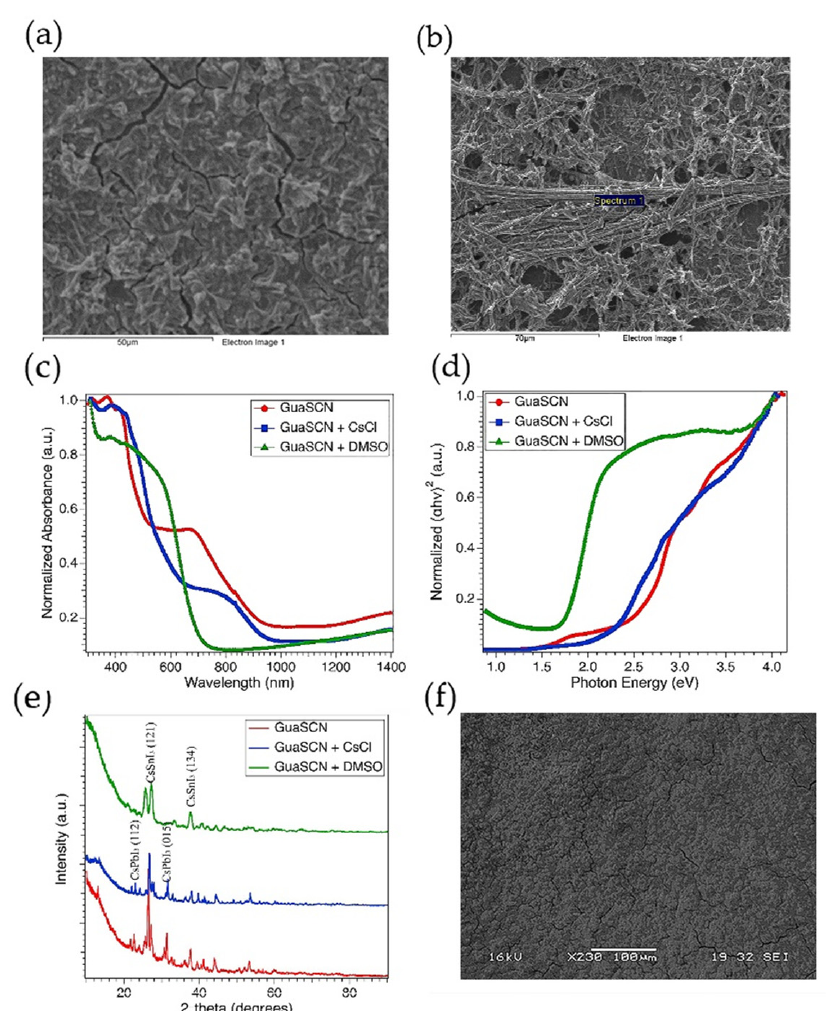
Figure 5. ( a ) Direct bandgap spectra shown in Tauc plot for GuaSCN film (red), when CsCl was added (blue), and when DMSO was used with other solvents (green); ( b ) Uv-Vis absorption spectra for similar types of films shown in ( a ); ( c ) XRD spectra with and without CsCl and DMSO; top-down SEM image of GuaSCN film ( d ), GuaSCN and CsCl combined ( e ), and GuaSCN and DMSO combined ( f